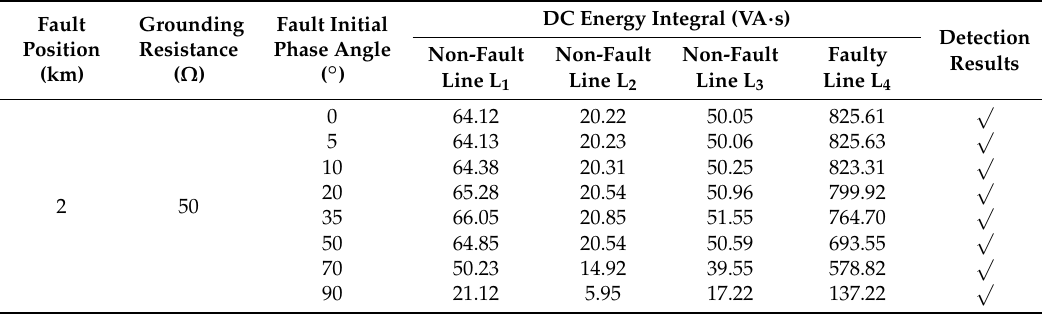
Table 5. DC energy integral under SPG faults with different initial phase angles.